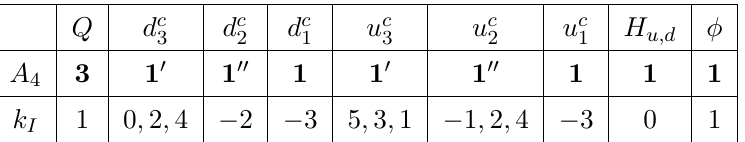
Table 3 . Natural A 4 models of quarks with a weighton (cid:30) . All 27 combinations of modular weights are considered in the text. Note that each supermultiplet has a modular weight (cid:0) k I